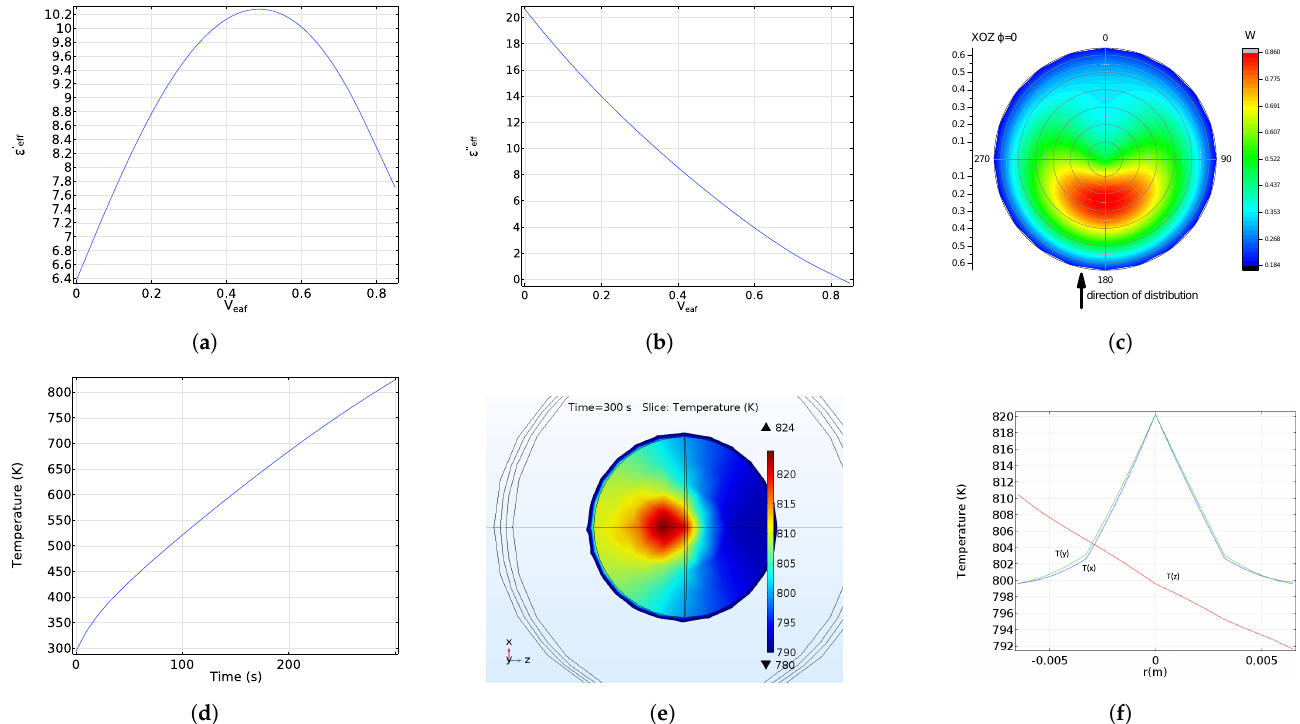
Figure 8. Dependencies of dielectric permittivity (real and imaginary parts) on the volume fraction of EAF dust for a biochar conductivity of σ eaf = 10 10.6 s − 1 ( a , b ). Distribution of heat sources (analytical solution for plane wave in free space) ( c ), temperature curve ( d ), and temperature distribution within pellet ( e , f